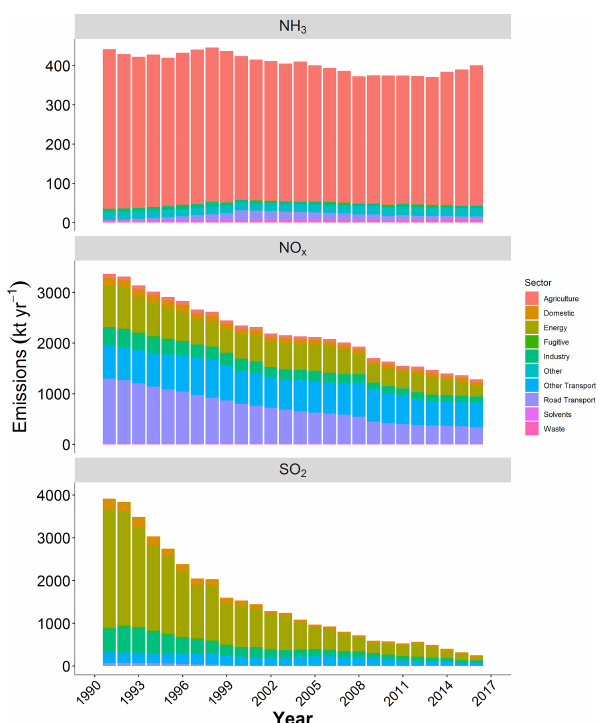
Figure 4. Emissions (in kt) of ammonia (NH 3 ), nitrogen ox- ides (NO x ) and sulfur dioxide (SO 2 ) in the model domain, covering the UK and Ireland, from 1990 to 2017, split into the main broad reporting